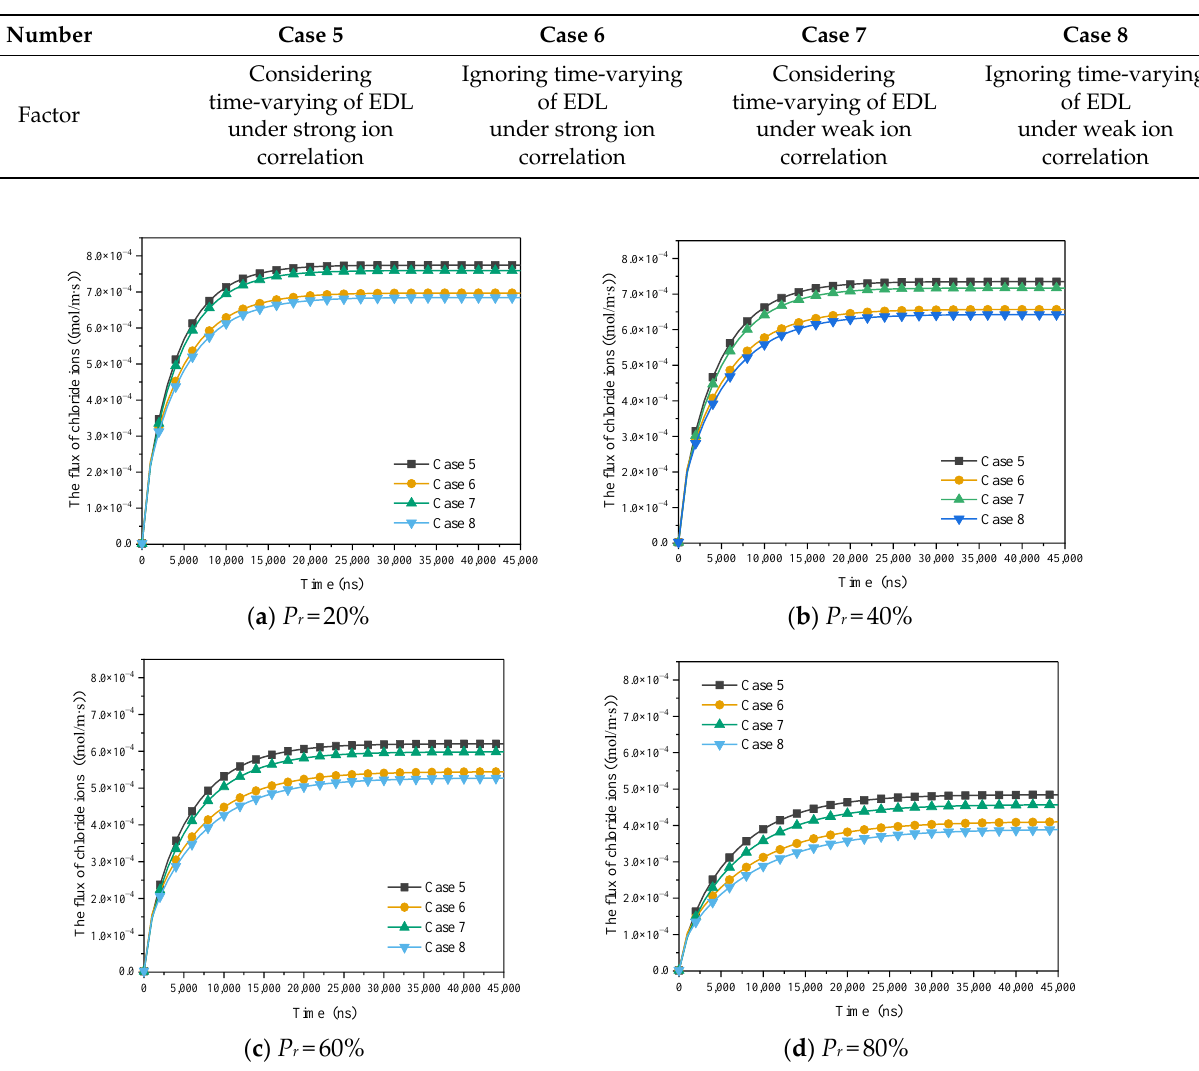
Figure 14. The influence of EDL time-varying on molar flux of chloride ions.